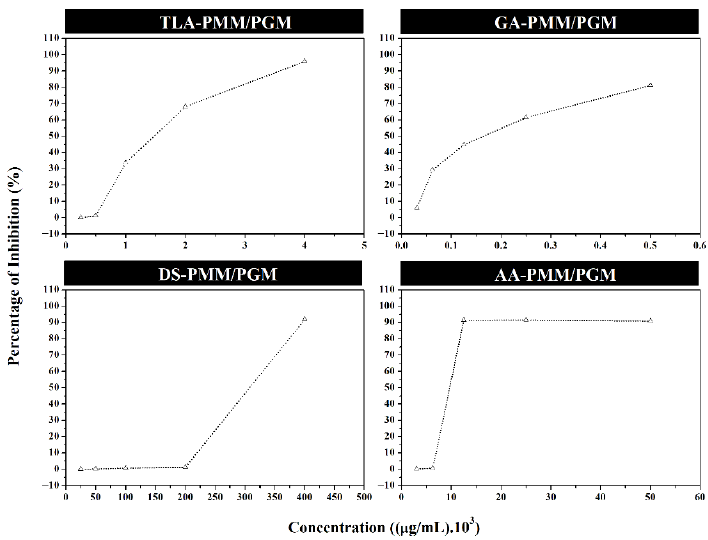
Figure 8. Inhibitory activity of Pseudomonas aeruginosa biofilm formation by TLA, glucaric acid (GA), D-sorbitol (DS), and ascorbic acid (AA) in vitro using the crystal violet method on 96-well microtiter plates.